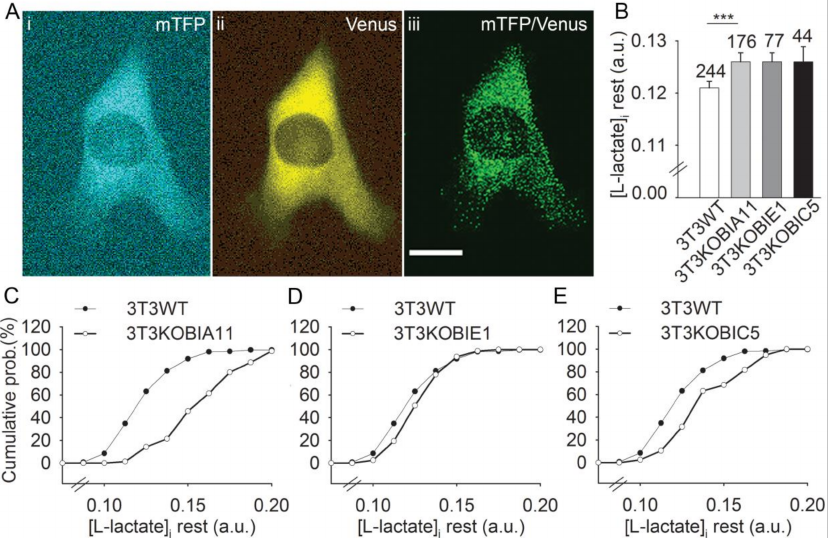
Figure 5. Resting levels of [lactate]i in 3T3GPR27KO cells (3T3KOBIA11, 3T3KOBIE1 and 3T3KOBIC5) are increased in comparison with 3T3WT. ( A ) Fluorescent micrographs display resting 3T3 cells ex- pressing the lactate nanosensor Laconic: ( i ) mTFP channel visible in cyan, ( ii ) Venus channel visible in yellow and ( iii ) mTFP/Venus ratio, a parameter related to levels in [lactate] i ; the lowest mTFP/Venus ratio in the background is represented as black pixels; green pixels represent mTFP/Venus ratio > 0. For calculation of the average cell resting levels of [lactate] i , the region of interest included the whole cell image area. Scale bar, 20 µ m. ( B ) Average resting [lactate]i levels measured with the Laconic FRET ratio signal (mTFP/Venus) revealed that in 3T3KOBIA11 cells, resting [L-lactate]i is significantly in- creased (one-way ANOVA on ranks and Mann–Whitney rank sum test for the comparison of isolated groups; *** p ≤ 0.001). Numbers adjacent to bars are the number of cells analyzed. The distribution graphs show the comparison of the cumulative frequency distribution of the average basal FRET ratio signals in arbitrary units (a.u.) representing resting [L-lactate]i in single 3T3 wild-type cells (WT, black circles) and in ( C ) 3T3KOBIA11, ( D ) 3T3KOBIE1, ( E ) 3T3KOBIC5 cells (white circles). The resting value frequency distributions of the three 3T3KOB cells were tested for equality against the resting value distributions of the 3T3WT cells with the two-sample Kolmogorov–Smirnov test. The frequency distributions obtained in 3T3KOBIA11 and 3T3KOBIC5 cells differ significantly from the 3T3WT distribution (D (3T3KOBIA11) = 0.597 > 0.134; D (3T3KOBIC5) = 0.315 > 0.222); the frequency distribution in 3T3KOBIE1 cells is not different from